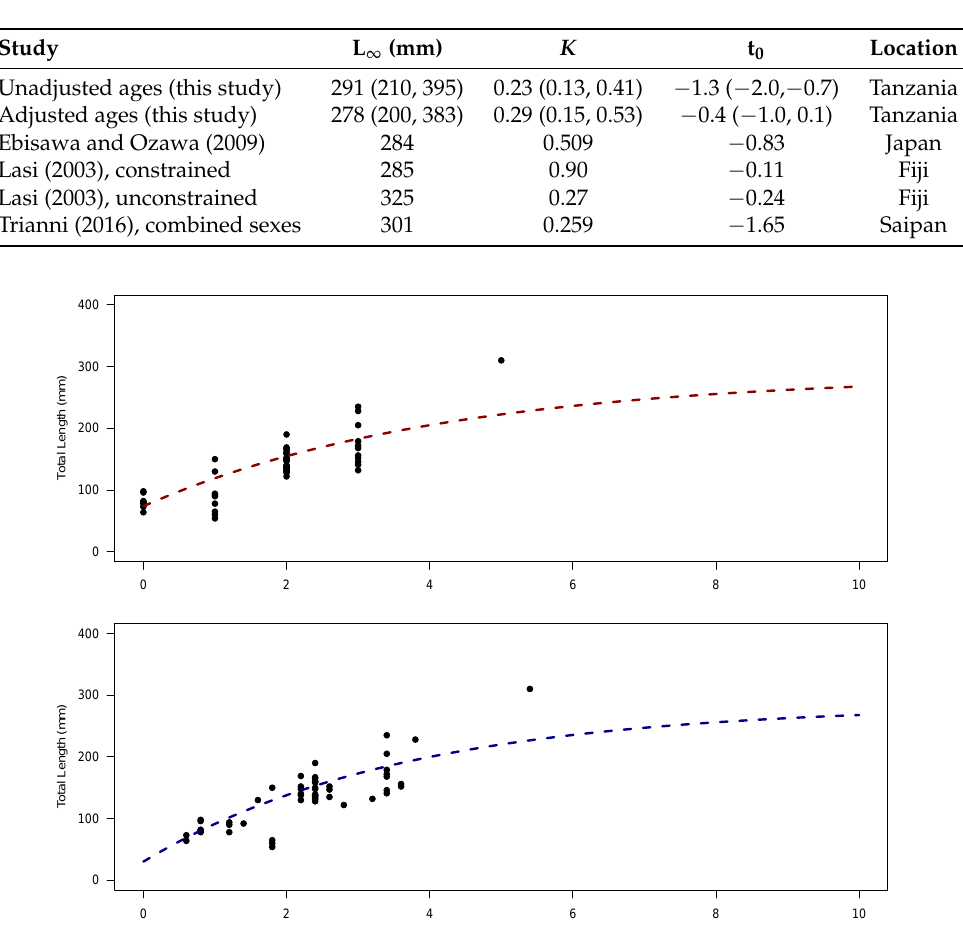
Figure 4. Von Bertalanffy model fits to L. harak age and growth data. The top panel represents individual fish aged with whole ages, and the bottom panel represents a fractional age based on amount of growth between the final increment (annuli) and margin. Both Von Bertalanffy models were estimated with similar parameter